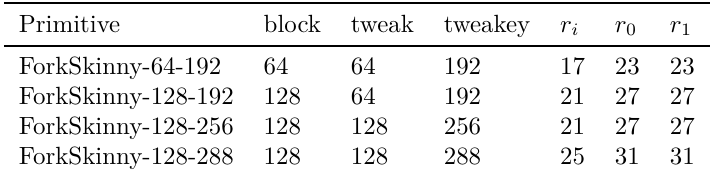
Table 3: ForkSkinny